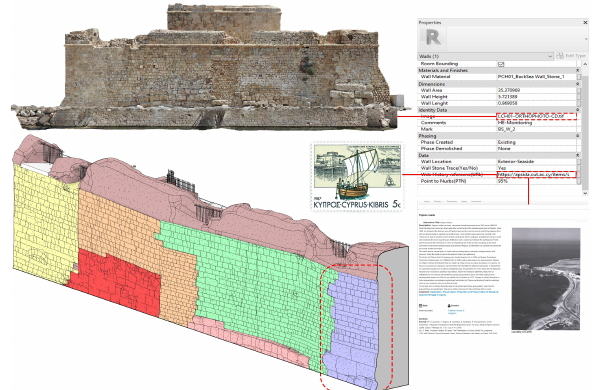
Figure 10. The seaside wall that is been generated using the suggested adaptive algorithm linked with the related data such as orthophotos, geometry characteristics and web archives.